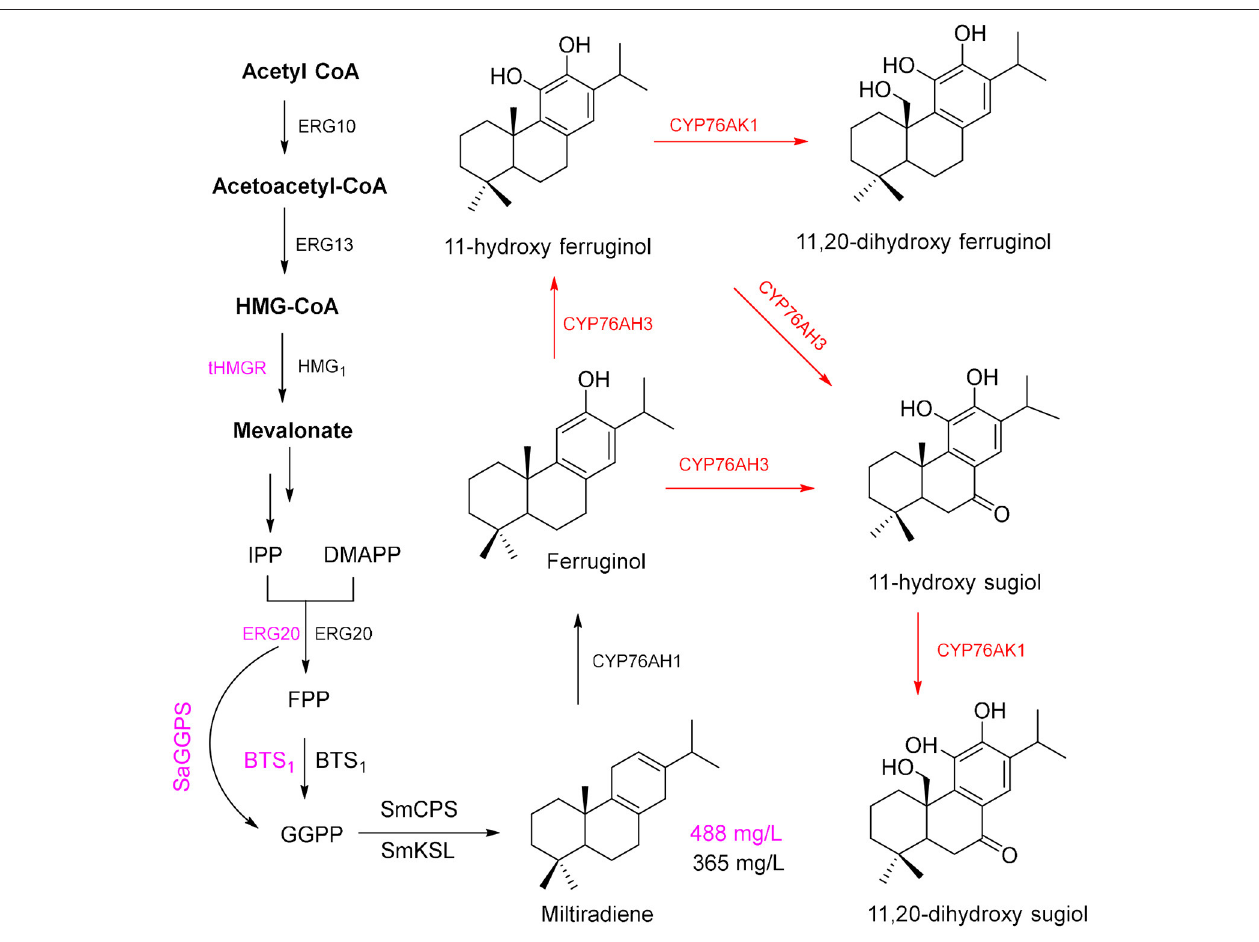
FIGURE 4 | Production route for tanshinone